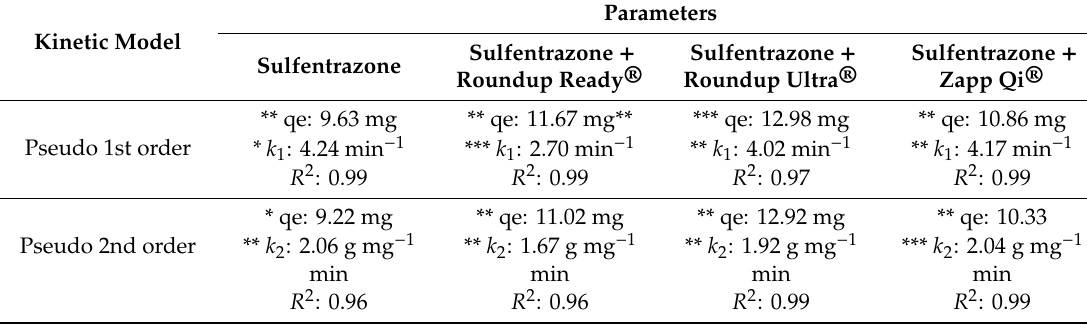
Table 2. Parameters of the pseudo-first order and pseudo-second order models for the adsorption of sulfentrazone in isolation and mixed with glyphosate